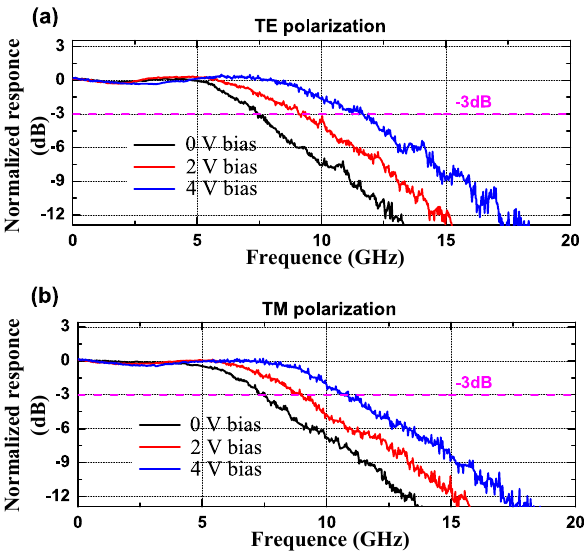
Figure 8: The high frequency response of the fabricated device (normalized S 21 response): (a) TE polarization, (b) TM